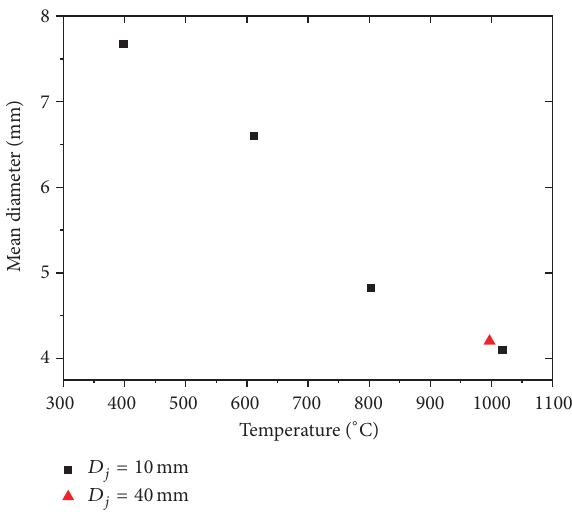
Figure 10: Mean debris diameter for the five tests.